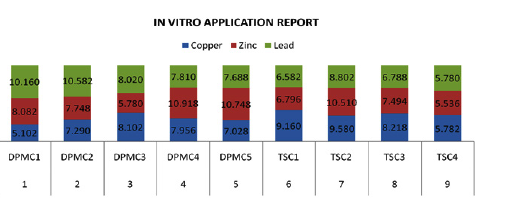
Fig. 6. In vitro Application